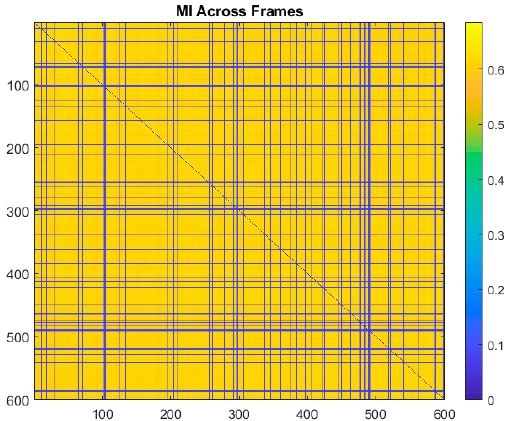
Figure 13. Normalized mutual information calculated between all the frames and one another.